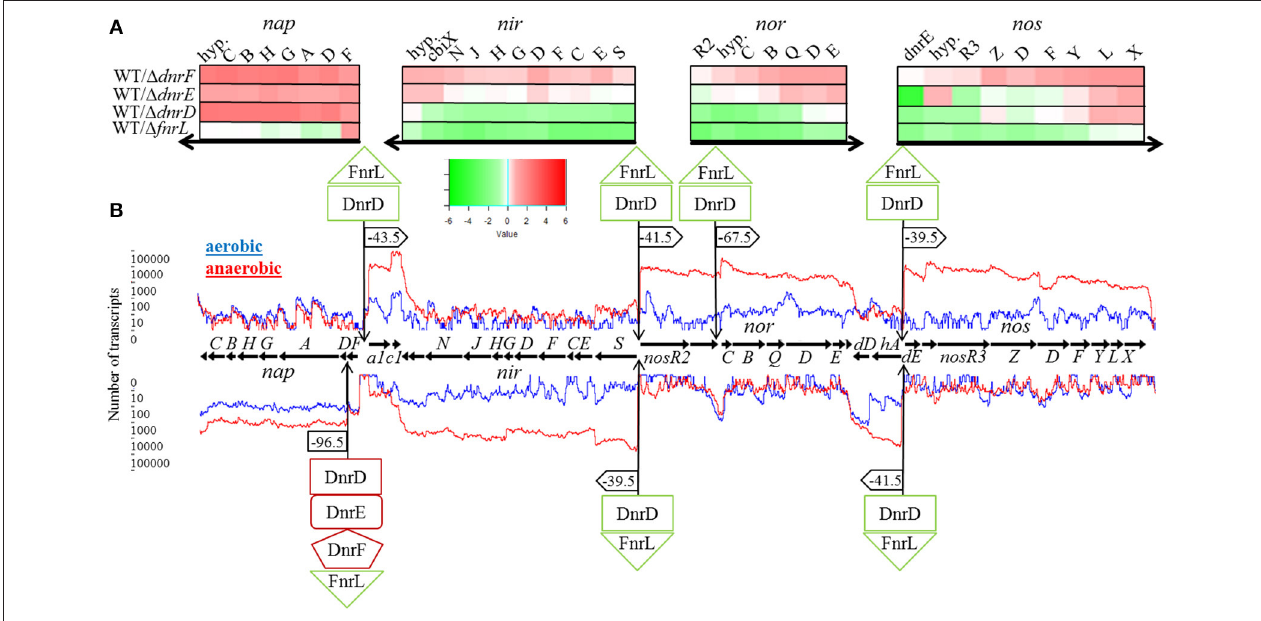
FIGURE 5 | Regulation of the denitrification operons by FnrL, DnrD, DnrE, and DnrF. (A) Heat map representation of denitrification gene expression patterns of mutant strains DS001( 1 fnrL ), DS002( 1 dnrD ), DS003( 1 dnrE ), and DS004( 1 dnrF ) compared to D. shibae DFL12 T wild type strain grown under anaerobic conditions. The colored bars represent the expression level in log2 scale. Green indicates a relatively low expression level in the mutant strain which indicates activation by the regulator; red indicates relatively high expression levels in the mutant strain compared to the wild type indicating repression. (B) Denitrification operons with corresponding RNA sequencing data based transcriptional start sites and transcript quantification under aerobic (blue line) and anaerobic conditions (red line) of the wild type D. shibae DFL12 T . Black horizontal arrows indicate open reading frames and the direction of transcription. Additionally, binding sites of FnrL, DnrD, DnrE, and DnrF are indicated by flags. If the corresponding binding site was located within a promoter sequence, the corresponding distance to the transcriptional start was given. Green boxes indicate an activation by the given regulator, red boxes indicate a repression. a1 , apbE1 ; c1 , cycA1 ; hyp , hypothetical gene; dD , dnrD ; hA , hemA3 ; dE , dnrE